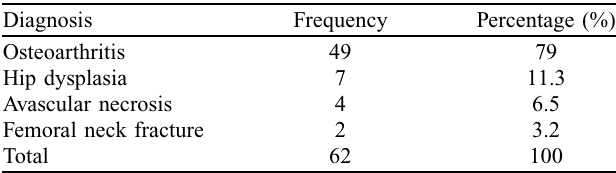
Table 1. Distribution of the indications of MiniHip TM short stem prosthesis among